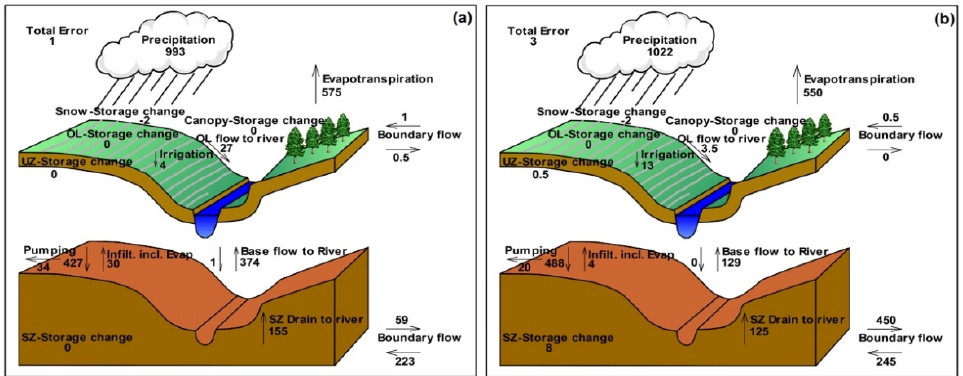
Figure A1. The MIKE-SHE graphical water balance output: ( a ) for catchment A (which, is a positive/inflow condition) and ( b ) for catchment B (which, is a negative/outflow condition) for the period 2000–2010, see Figure 1b for the location of the catchments. In the graph, inflows (out-flows) to (out of) the catchment are illustrated as leftward (rightward) arrows. The unit is mm/year in all the variables. OL: overland, UZ: unsaturated zone, and SZ: saturated zone.